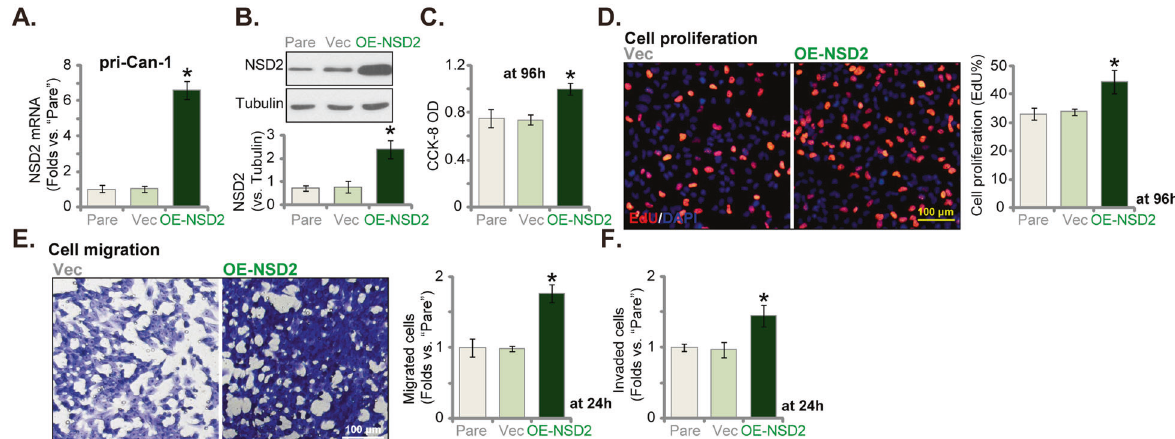
Fig. 5 Ectopic overexpression of NSD2 can expedite CRC cell proliferation and migration. Stable primary human colon cancer cells, pri- Can-1, expressing a lentiviral construct encoding the full-length NSD2 cDNA ( “ OE-NSD2 ” ) or empty vector ( “ Vec ” ), were established. Expression of NSD2 mRNA ( A ) and listed proteins ( B ) were shown. Cells were further cultured for applied time periods; cell viability (CCK-8 OD, C ), proliferation (EdU staining assays, D ), migration, and invasion ( “ Transwell assays ” , E , F ) were tested, with results quanti fi ed. “ Pare ” stands for the parental control cells. Data were presented as mean ± SD ( n = 5). * P < 0.05 vs. “ Vec ” cells. Experiments in this fi gure were repeated fi ve times and similar results were obtained. Scale bar = 100 μ m ( D , E